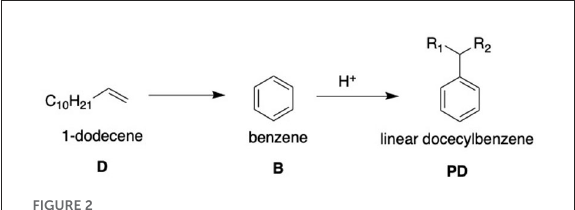
FIGURE2 A diagram-aided equation showing the basis of the DETAL process using an acid catalyst (after Yadav and Doshi,